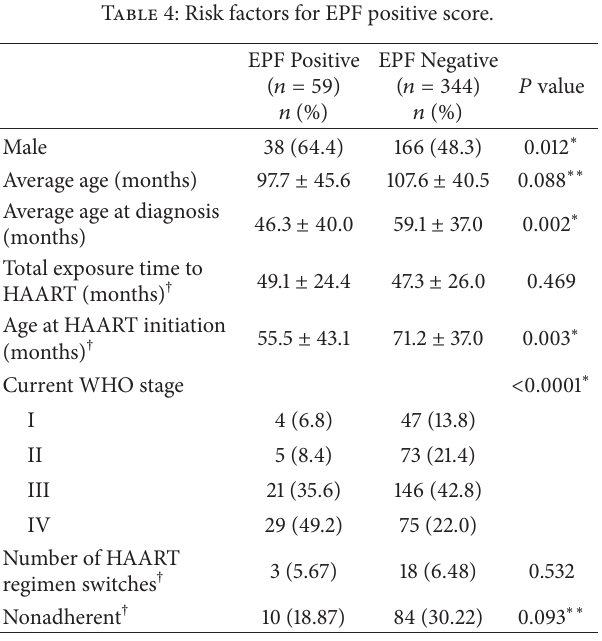
Table 4: Risk factors for EPF positive